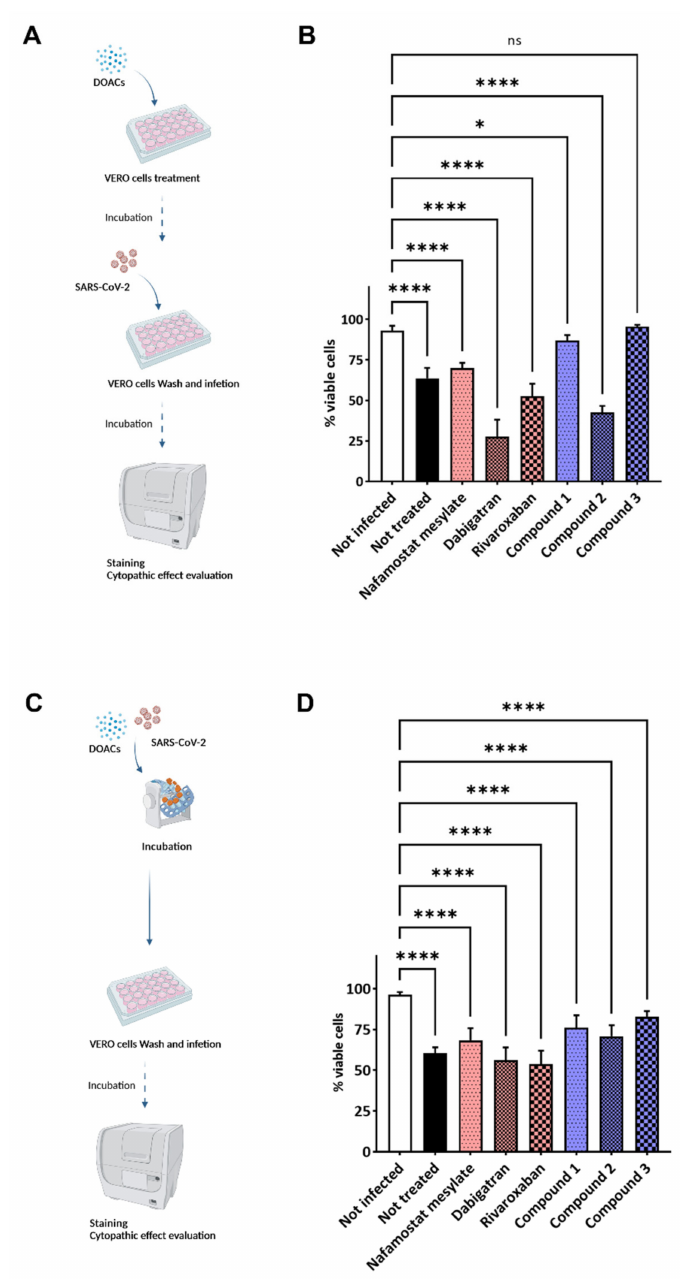
Figure 4. Schematic representations of the experimental settings and results. ( A , B ) Preincubation experimental setting: VERO cells were treated with the selected compounds diluted in cell culture medium at final concentration of 100 µ M for 2 before infection with SARS-CoV-2. ( C , D )